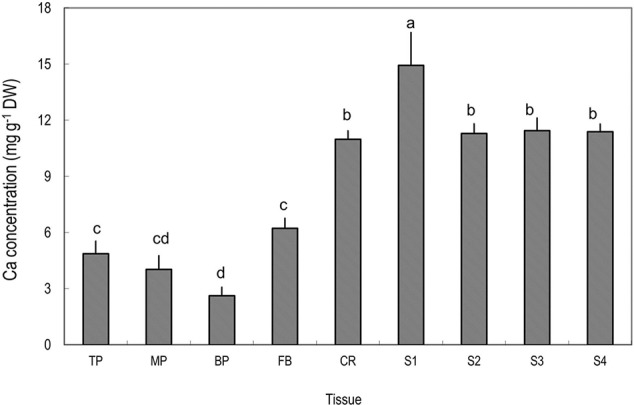
Calcium concentrations in different tissues of mature litchi fruit. Tissues represented by the labels on the X axial refer to Figure 1. Different letters above columns indicate significant difference among different tissues (P < 0.05, LSD, n = 5). Vertical bars represent standard errors of means.